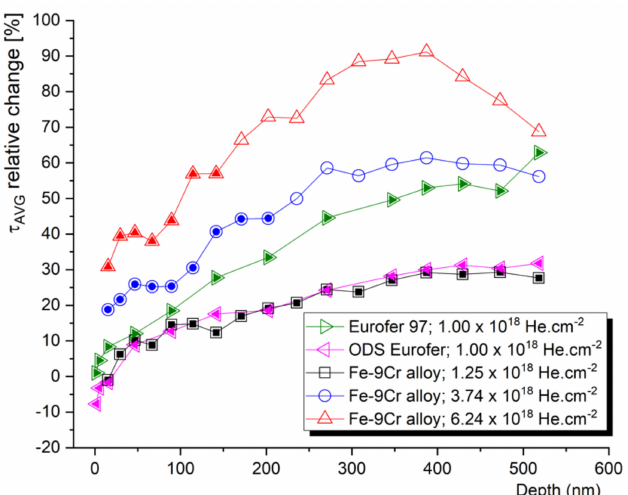
Figure 8. The increase in positron lifetime (implanted–unimplanted) as a function of the mean positron stopping depth. Filled symbols represent data with <50 at.% He, considered in further